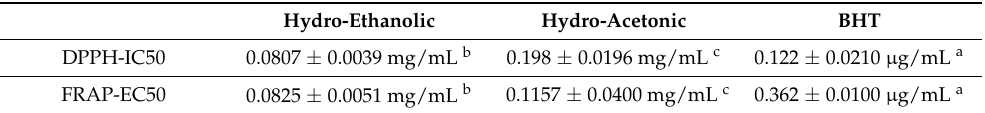
DPPH-IC50 and FRAP-EC50 of hydro-ethanolic and hydro-acetonic extracts of S. elaeagnifolium compared with BHT.